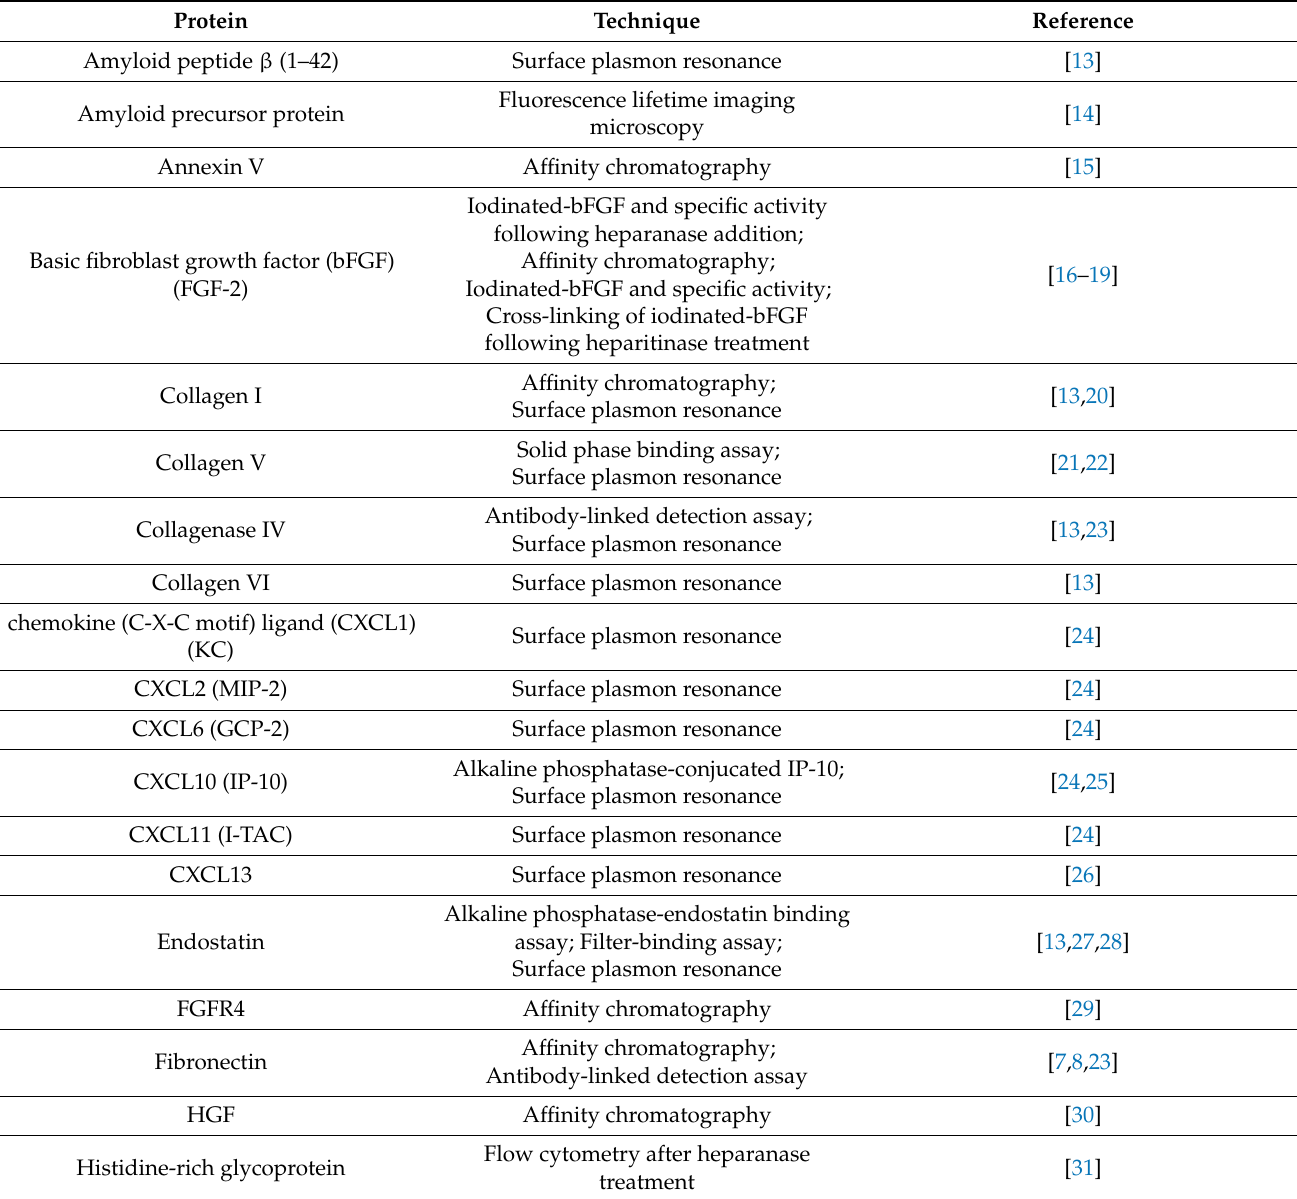
Table 1. Mammalian heparan sulfate-binding